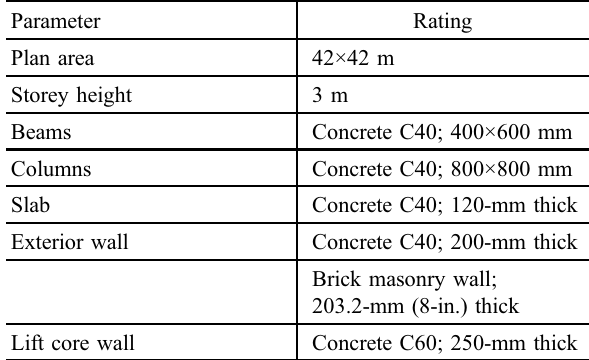
Table 1. Modelling and design information summary Parameter